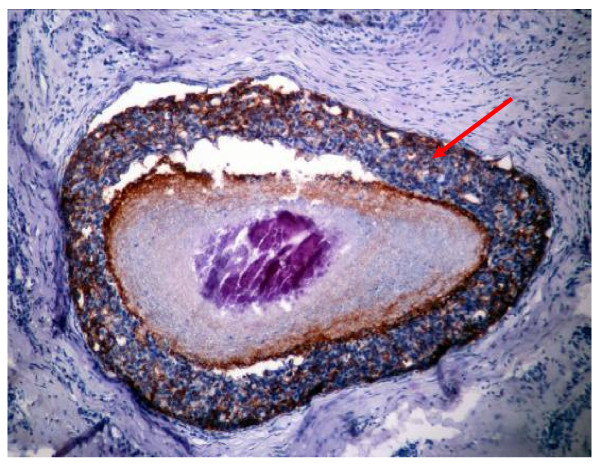
In situ ductal carcinoma of comedo type, showing strong membranous staining of Her2/neu, score 2+ (arrowed) (10×).